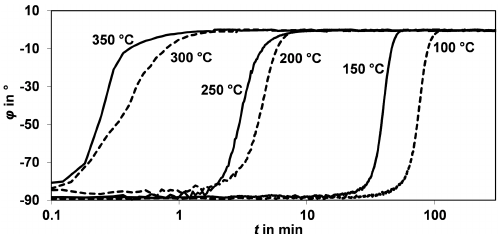
Figure 7. Example for the conductivity response of a single catalyst pellet during sulfidation (data: 500ppm H 2 S in N 2 , 400 ◦ C).